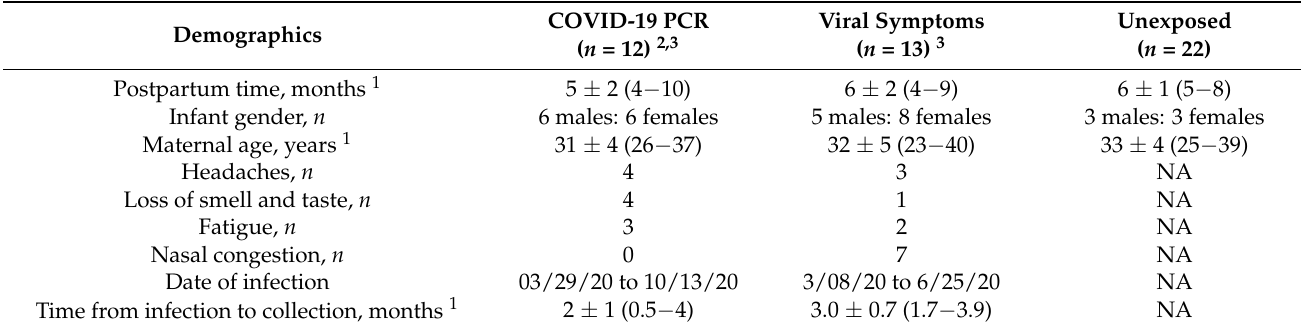
Table 1. Demographic description (self-reported) of mothers with confirmed COVID-19 PCR test, mothers with viral symptoms suggestive of COVID-19, and unexposed mothers (control pre-pandemic